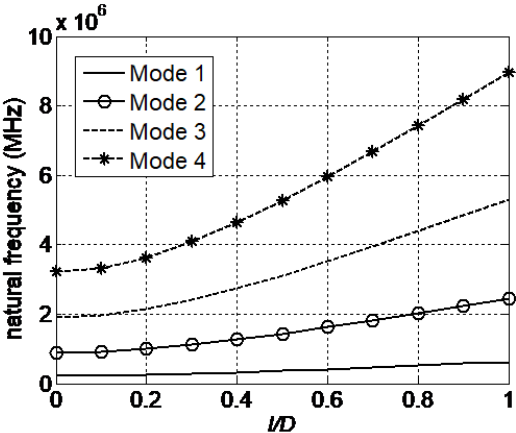
Figure 5: Effects of mode number and thickness-to-diameter ratio on the size-dependent natural frequencies of carbon nanotube dicted by Bernoulli-Euler beam model are always bigger than those evaluated by Rayleigh beam model and also the natural frequencies based on MCST are greater than those based on CT.